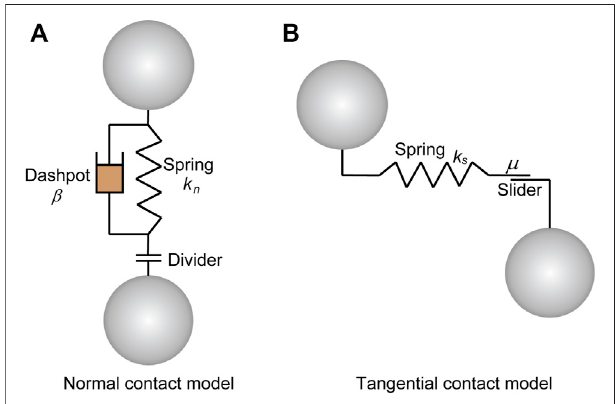
FIGURE 1 | The DEM contact model between two contacting particles. (A) Normal contact model, (B) Tangential contact